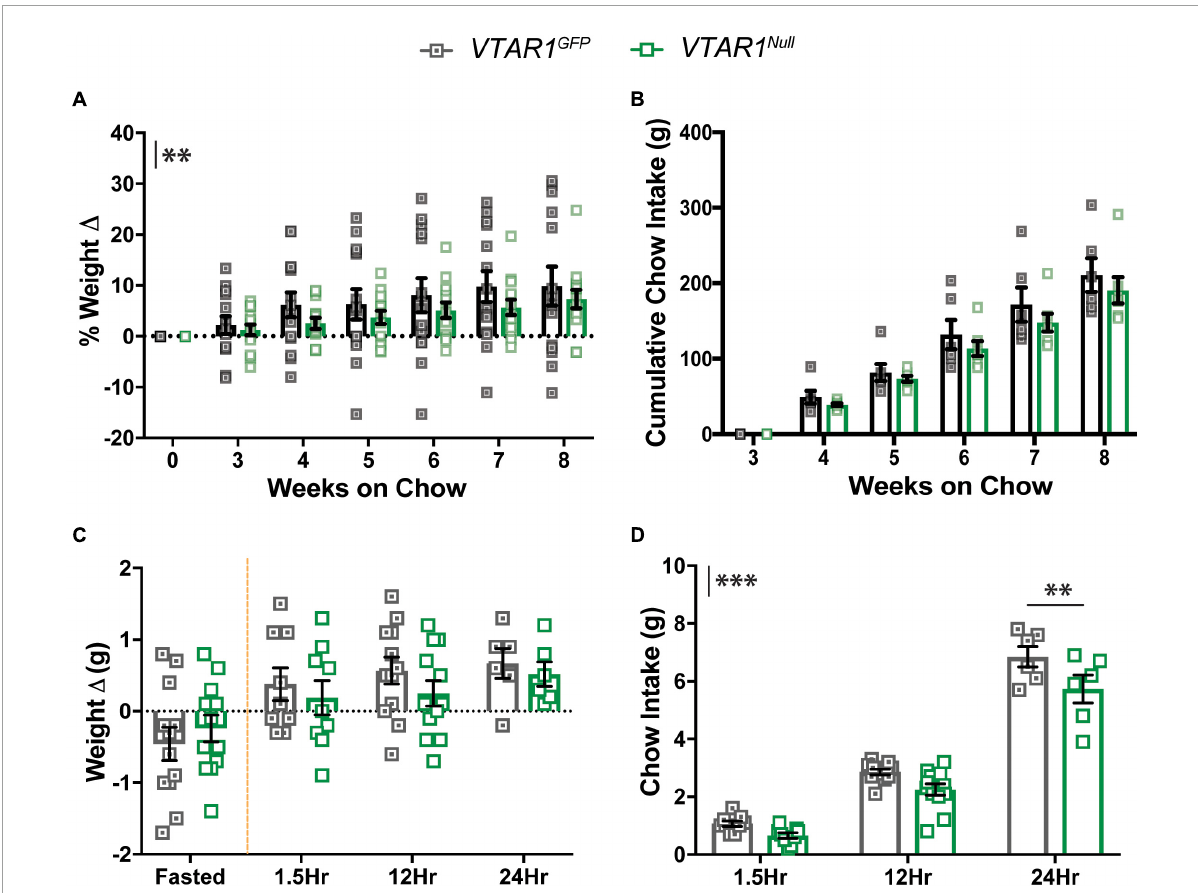
FIGURE7 Ventral tegmental area specific NtsR1 deletion in adulthood decreases body weight and DA-dependent chow intake. VTAR1 GFP and VTAR1 Null mice were individually housed immediately after surgery and their chow and body weight was measured weekly until the 8-week mark after surgery. (A) % weight change from surgery day to week 8 on chow and (B) cumulative chow intake. VTAR1 Null mice gain less weight compared to VTAR1 GFP mice. Data represent mean ± SEM analyzed via ordinary 2Way-ANOVA with Sidak’s correction. n = 6–13. VTAR1 GFP and VTAR1 Null mice were fasted overnight and then re-fed the next day with normal chow to assess whether adult NtsR1 deletion decreases DA-mediated food intake. Weight was measured ∼ 15 h after mice were fasted and 1.5, 12, and 24 h after food was restored. (C) Weight change before and after normal chow was restored. (D) Chow intake after chow was restored. VTAR1 Null mice on normal chow diet gained weight similar to VTAR1 GFP mice, but their chow intake was significantly reduced at 24 h. Data represent mean ± SEM analyzed via ordinary 2Way-ANOVA with Sidak’s correction for multiple comparisons. n = 12. Mark next to the y -axis in panels (A–D) indicates overall significant differences between genotypes. ** p < 0.01, *** p <